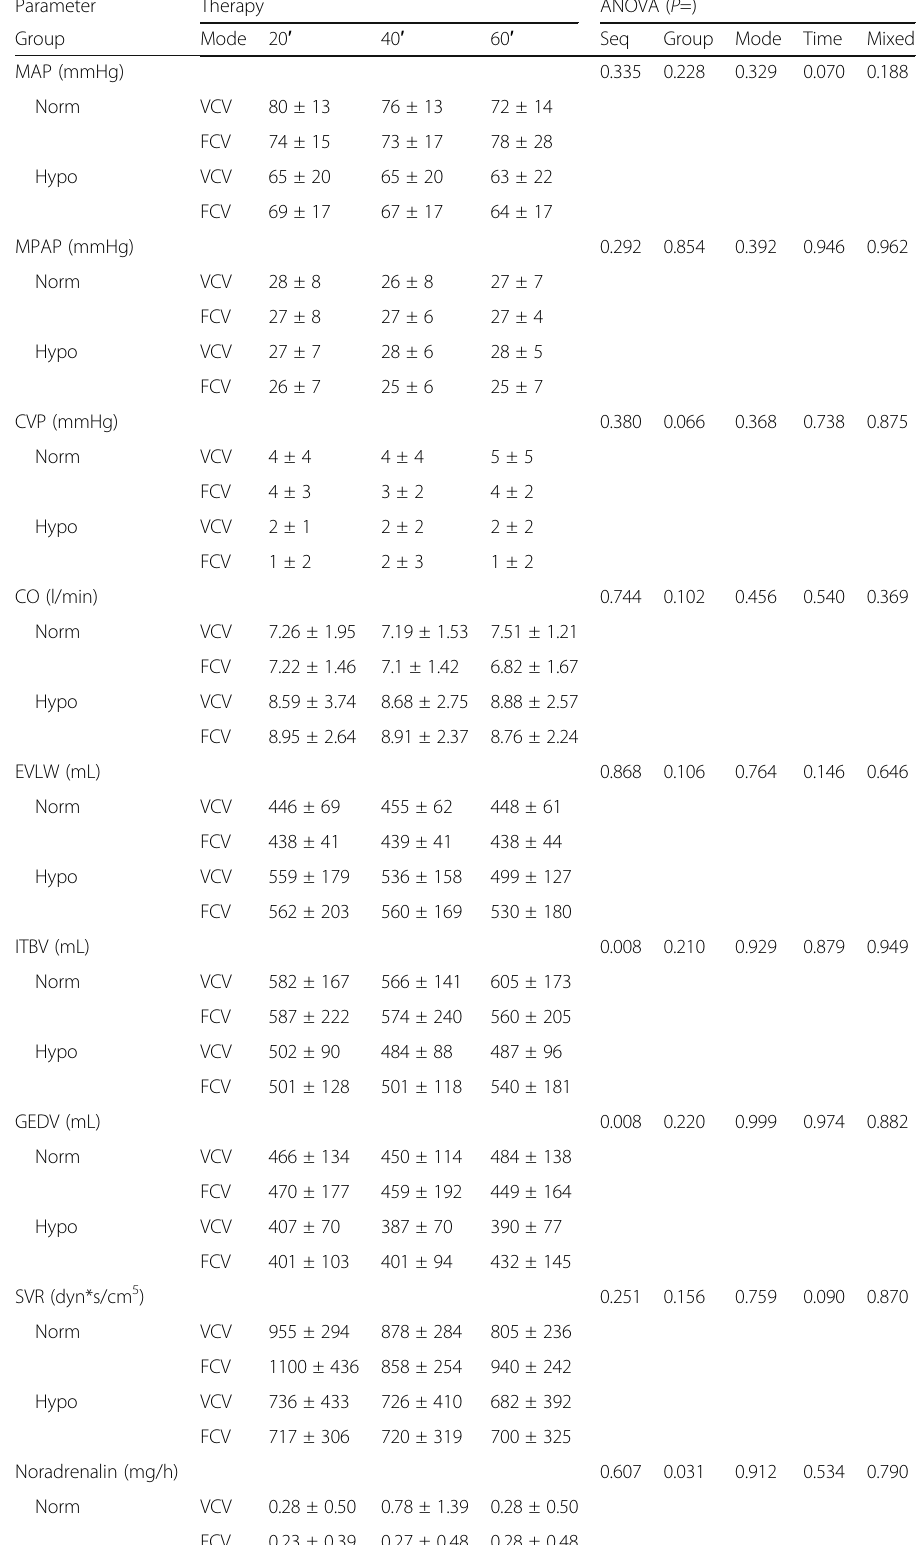
Table 1 Gas exchange and